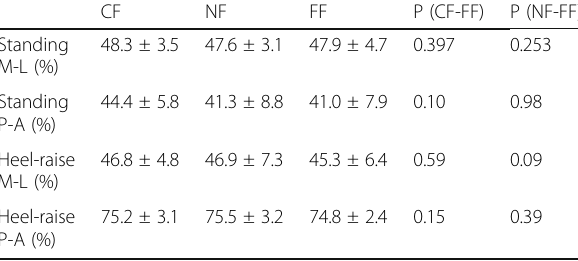
Table 3 Distribution of the center of pressure (Average for 10 s) CF NF FF P